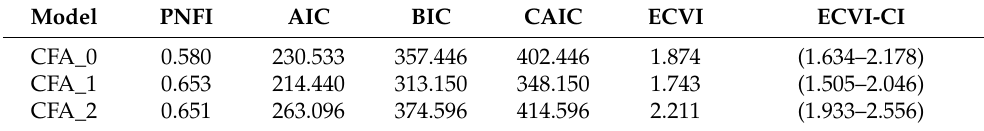
Table 3. Fit indices of parsimony-adjusted measures and information-theoretic